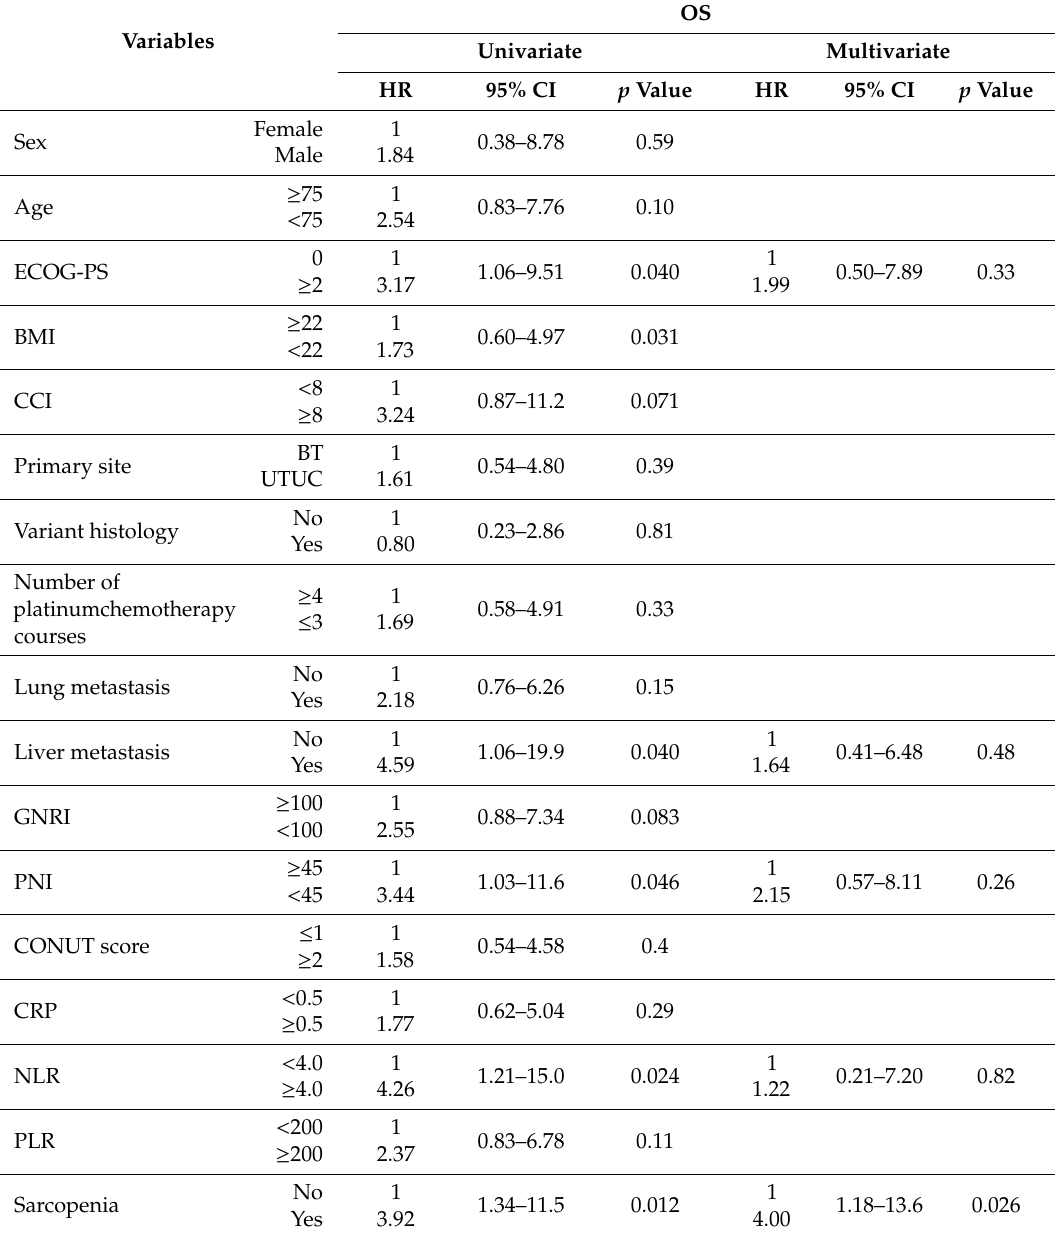
Table 3. Univariate and multivariate analysis of background factors for overall survival